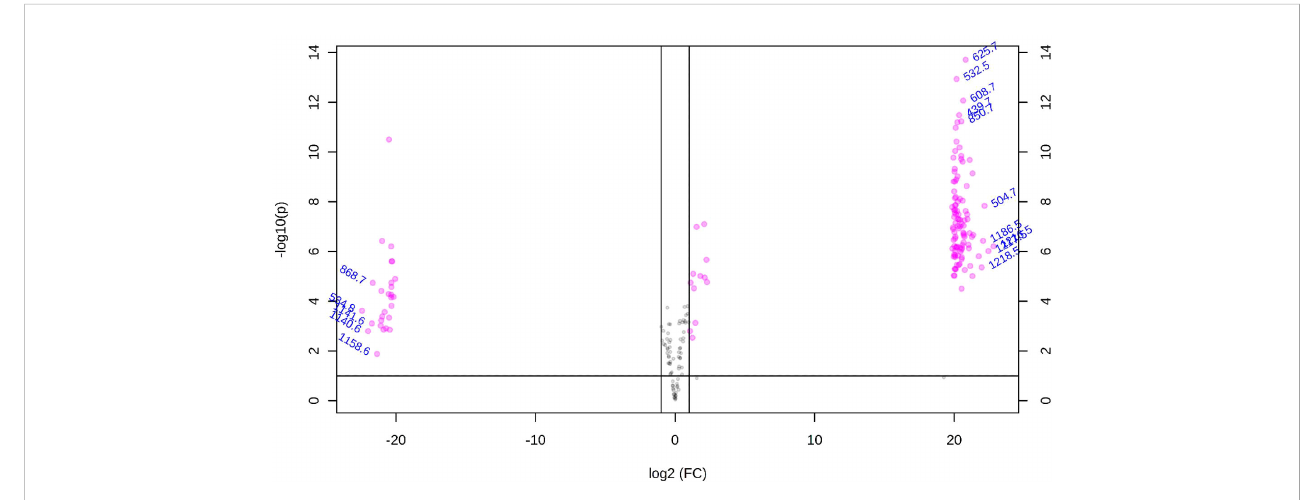
FIGURE 4 Volcano plot results of P. santalinus and P. tinctorius